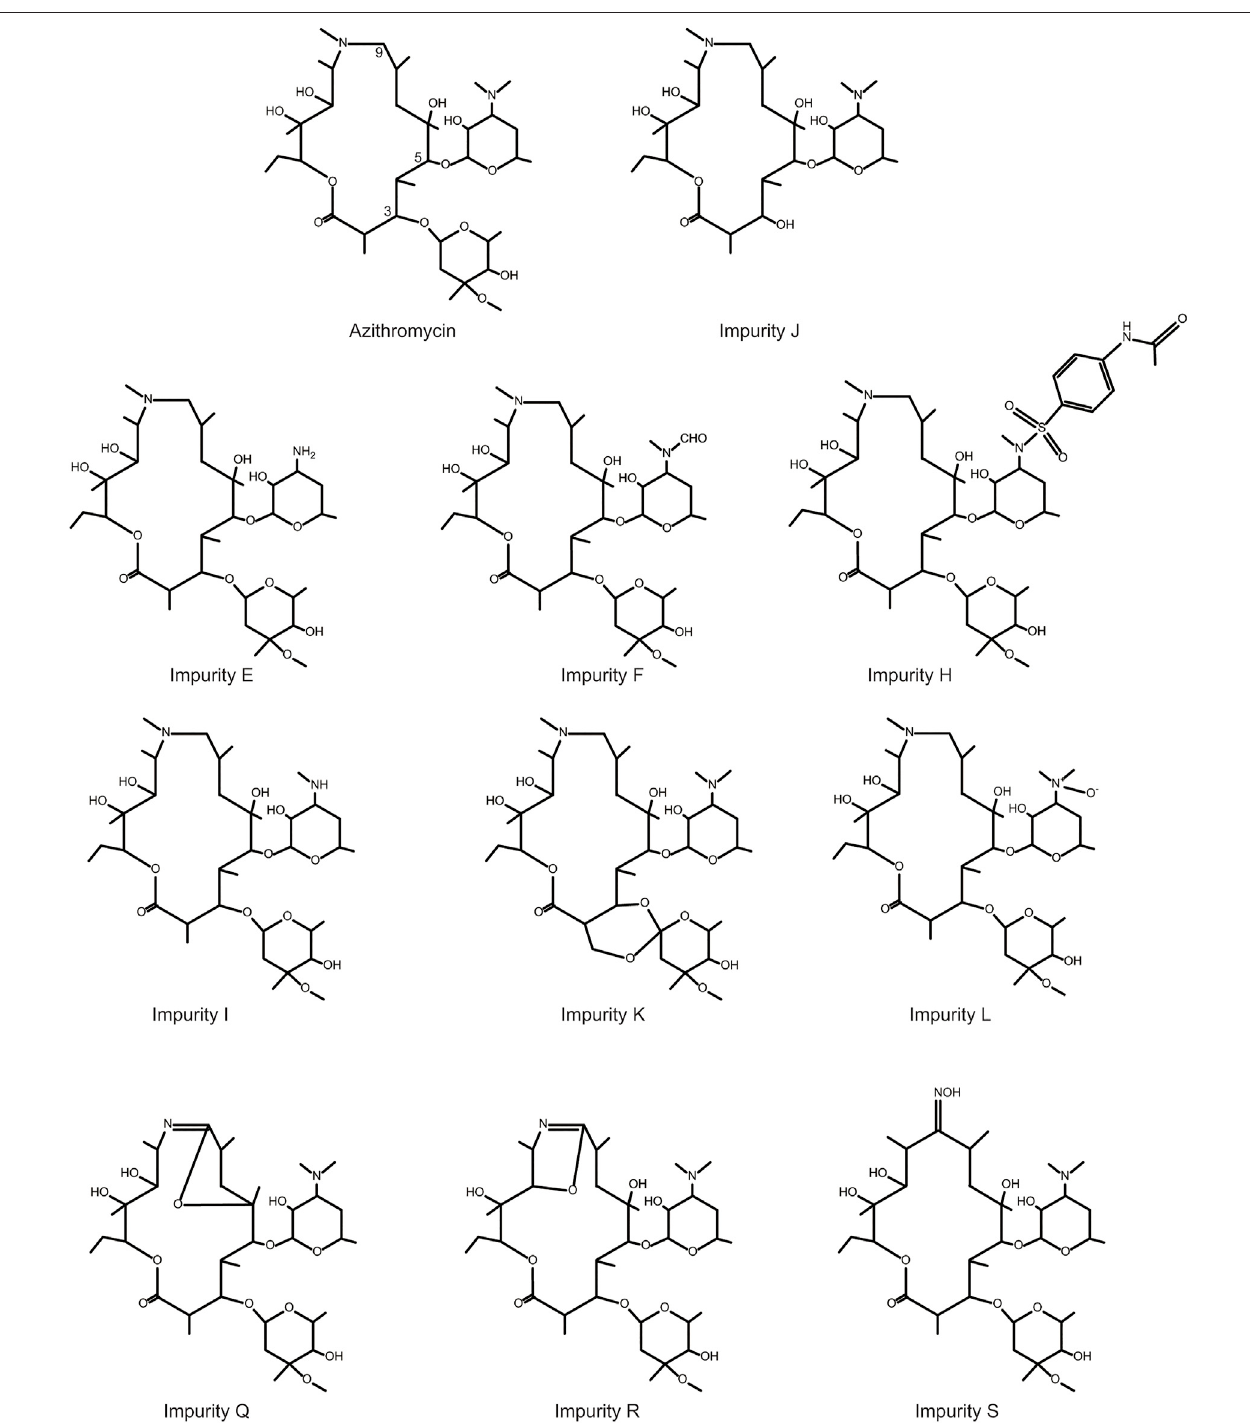
FIGURE 3 | Chemical structures of azithromycin and its related impurities used in this study.